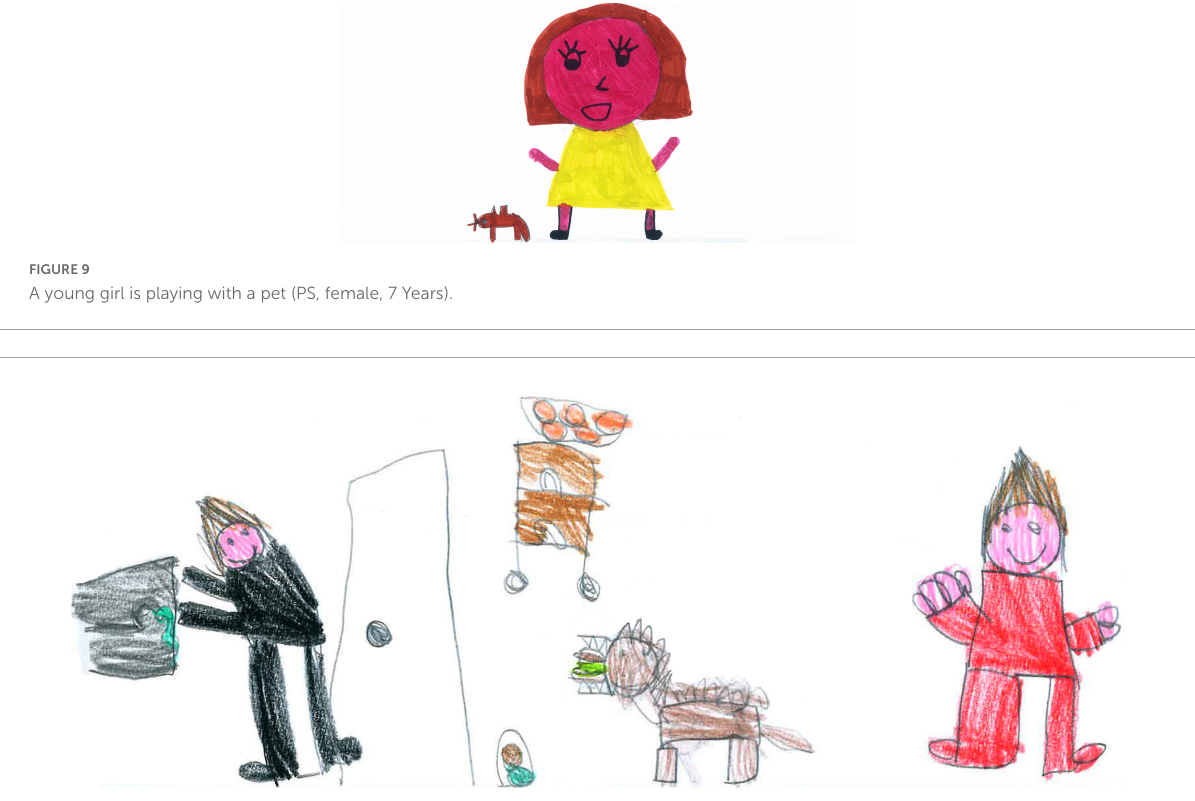
FIGURE10 A picture with a high score of distancing according to the PAIR scale. The subjects are separated and far apart, are doing a different activity, and are moving away from each other (PS, Male, 7 Years).